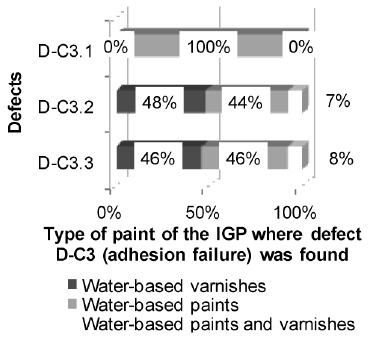
Fig. 6. Type of paint finish on IGPs where defect D-C3 (adhe- sion failure) was found